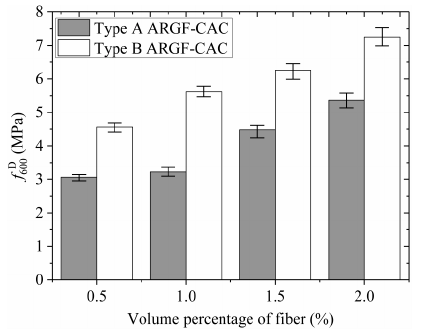
Figure 13. Variation of f r with fiber content.